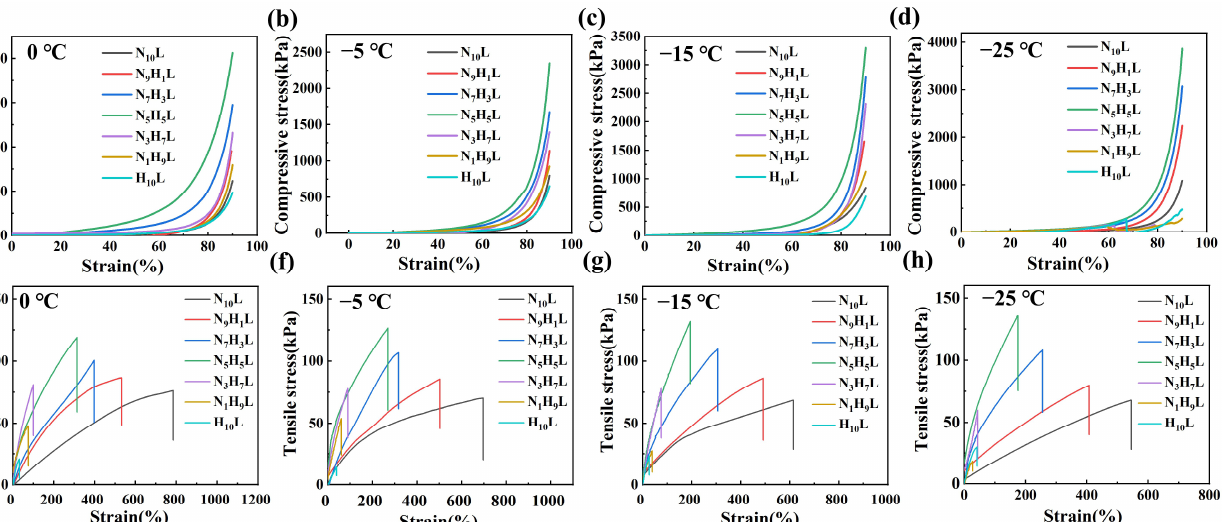
Figure 7. Schematic diagram of the anti-freezing properties of NC organohydrogels.